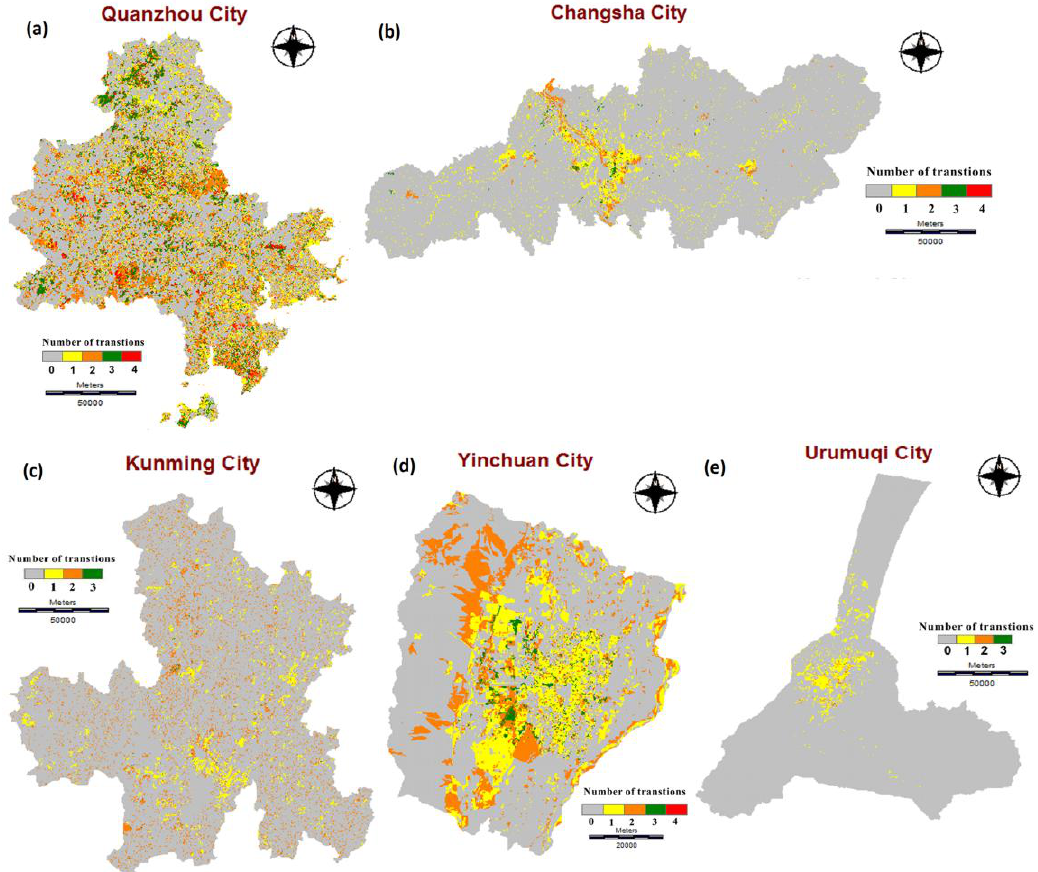
Figure 3. The Incidents map in the typical